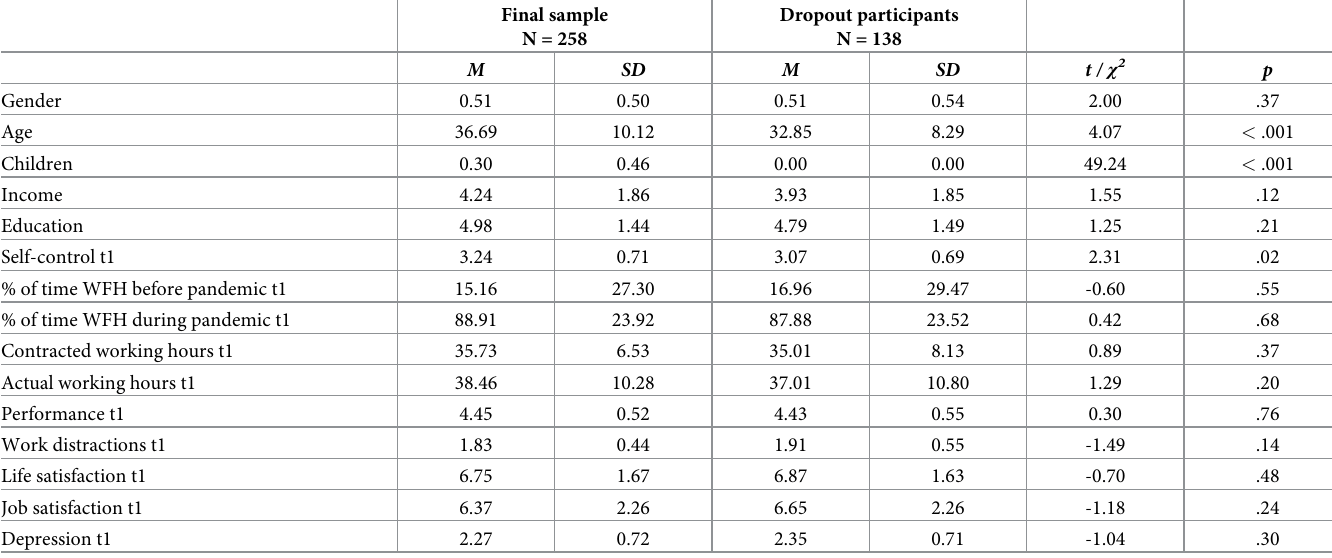
Table 1. Summary statistics for the sample (N = 258) and check for differential attrition.